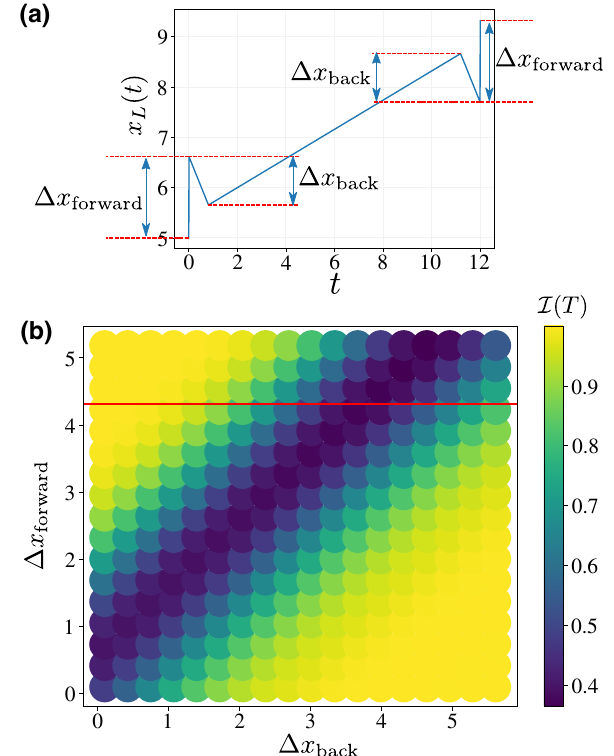
FIG. 3. (a) Setup of the ML-inspired simple control strategy consisting of two edge pulses with a forward jump (cid:3) x forward and backward jump (cid:3) x back together with a constant linear motion in between the dressed jumps. (b) Infidelity I ( T ) surface plot for the scans over the free parameters (cid:3) x forward and (cid:3) x back of the model strategy with (cid:3) t back = 0.07 w − 1 and (cid:3) t forward = 0.01 w − 1 in regime (I) ( l = 4.32, T = 12 ) . The red line indicates the line where the size of the forward jump (cid:3) x forward is equal to the total movement length l . The parameters of the Majorana control setup are the same as in Fig. 2. The optimal dressed jumps appear at a diagonal set of parameters (cid:3) x forward − (cid:3) x back ∼ C , where C ≈ 0.96. We note that the best protocol has a jump size bigger than the movement length (cid:3) x forward > l , which means that it jumps over the target position x L ( T ) = x B and then jumps back within the range x A < x L < x B , as can be seen in Fig. 1 (d) [for